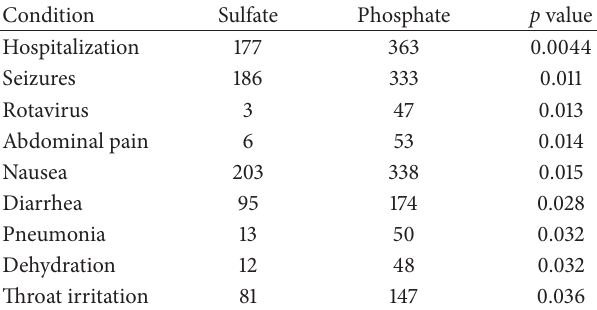
Table 8: Counts of various adverse reactions reported in VAERS for sulfate versus phosphate in age-matched equal subsets of the sample space, and the likelihood that the contrasts observed in these distributions could have occurred by chance according to a log likelihood ratio test. Included are all the reactions for which phosphate was more common with a p value under